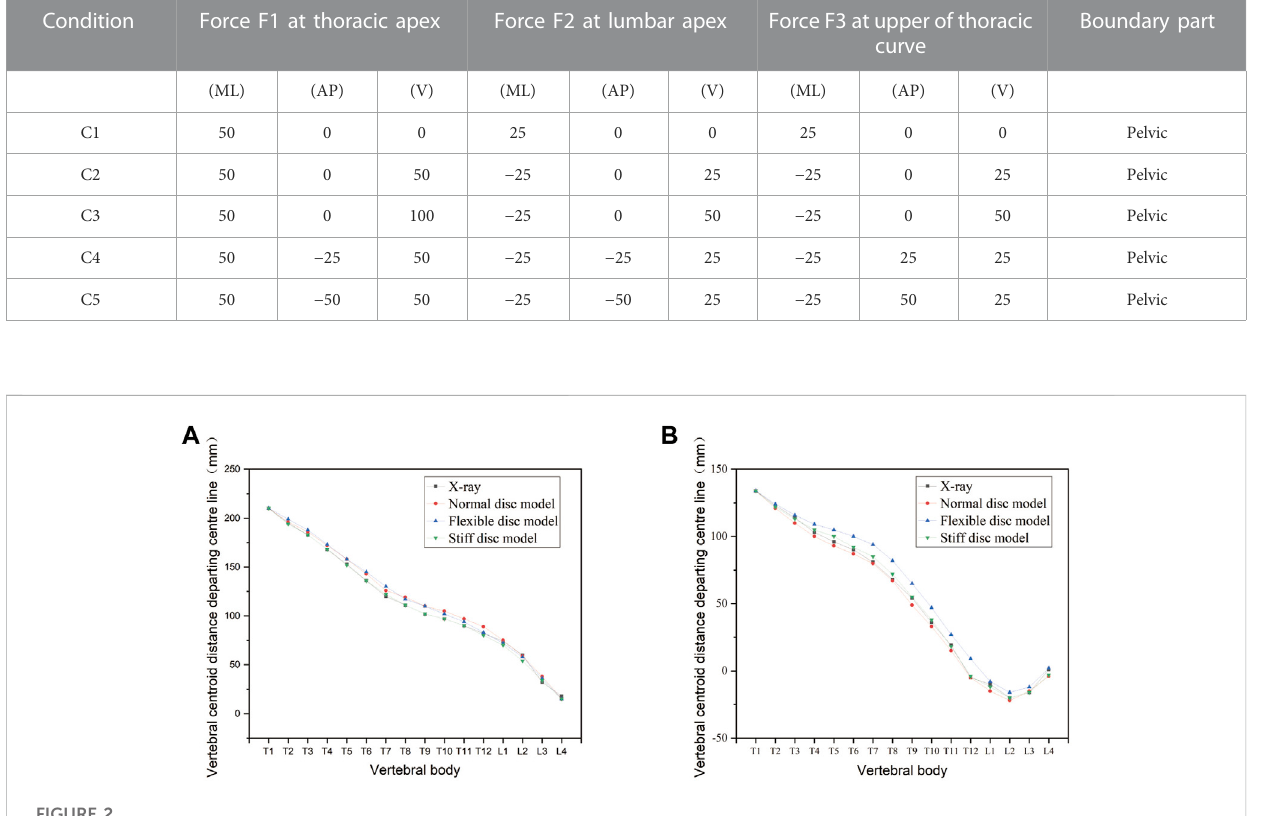
Boundary part curve